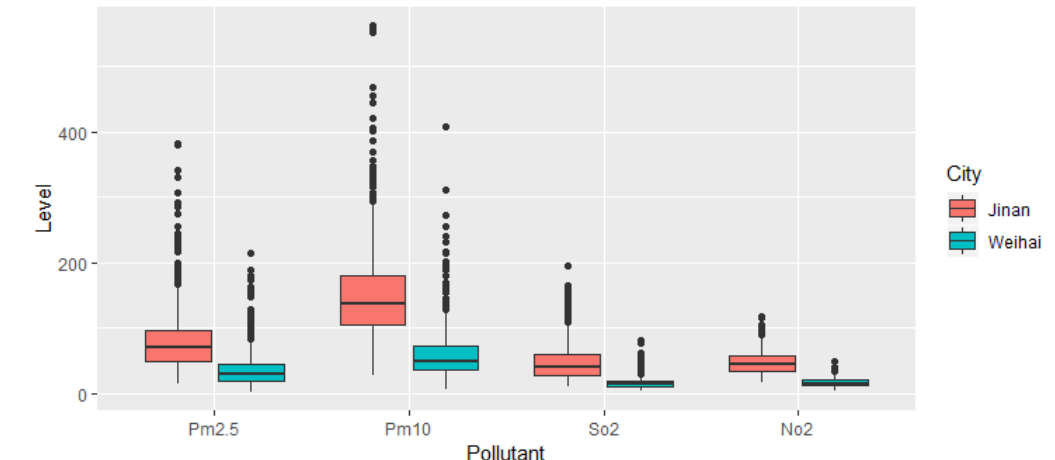
Figure 2. A boxplot of daily mean air pollution levels in Jinan and Weihai.